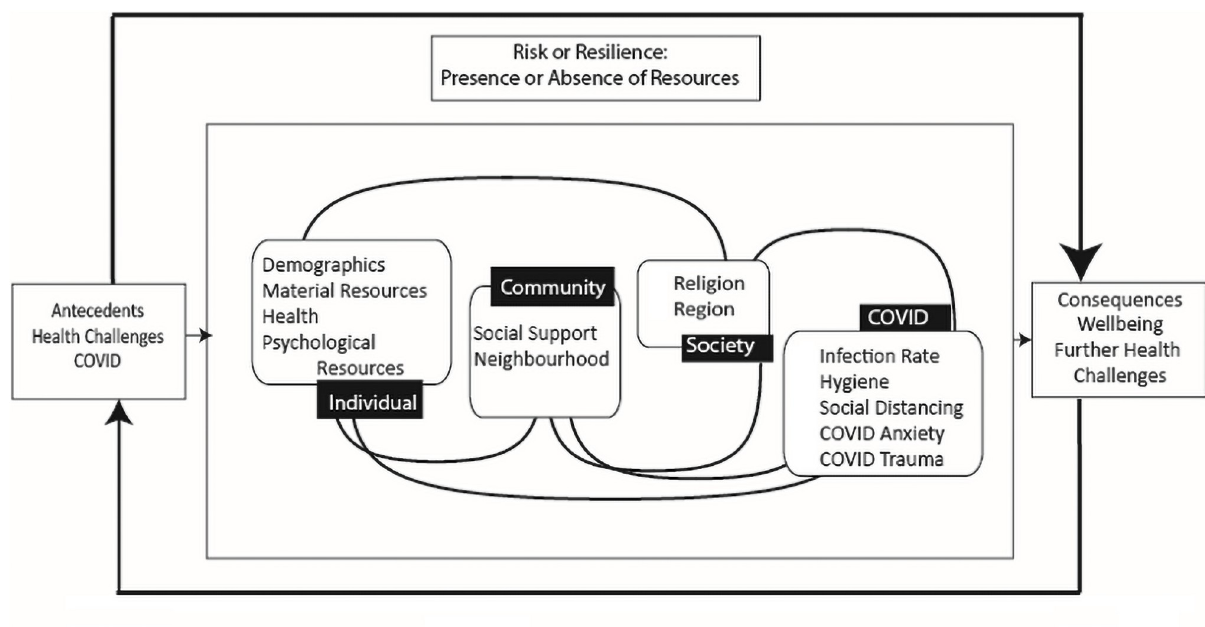
Fig 2. The ecological model of resilience adapted to the context of COVID-19. In this model we present those variables–individual, community, and societal–that were available in the Italian dataset to be tested. We have introduced specific variables in a COVID-19 level. Psychological variables which were significantly associated with resilience (+) and non-resilience (-) are: conscientiousness (+), neuroticism (-), death anxiety finality (+), intolerance of uncertainty (-), loneliness (-), and brief resilience scale (+).